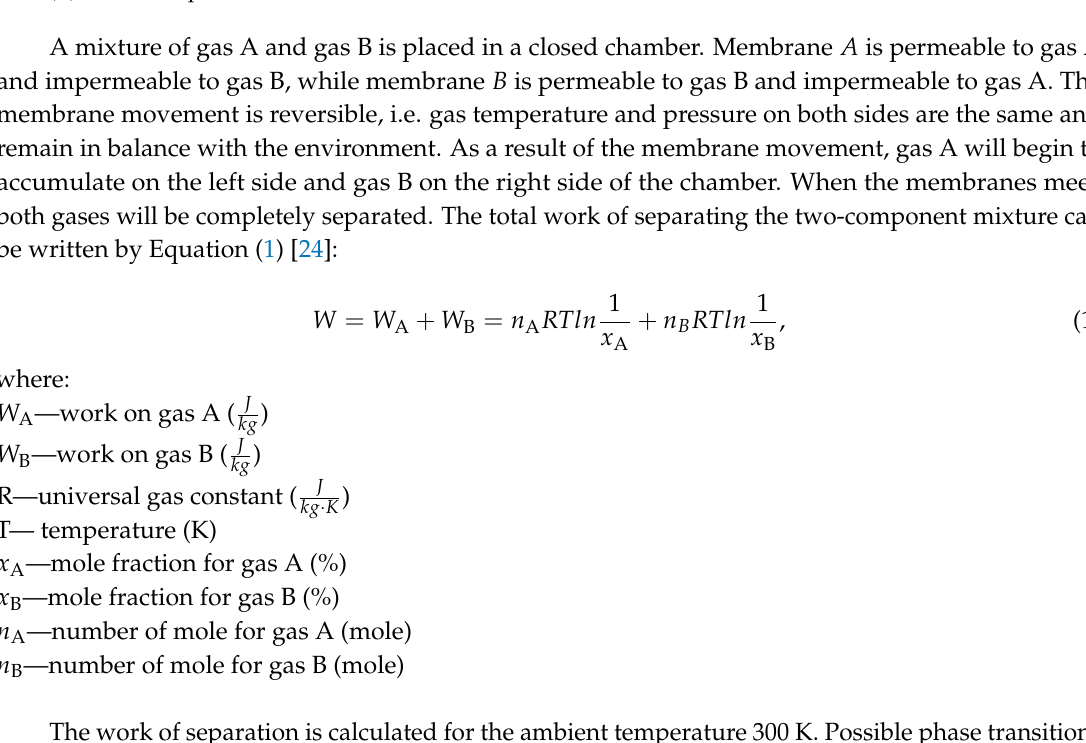
Figure 2. Separation of gas mixture using semipermeable membranes: ( a ) beginning of the process ( b ) end of the